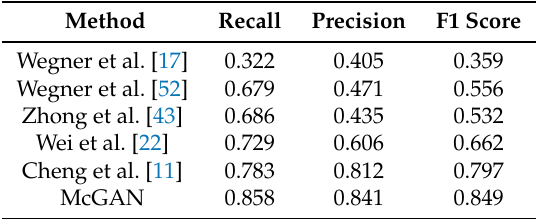
Table 4. Quantitative statistics of different methods on Massachusetts